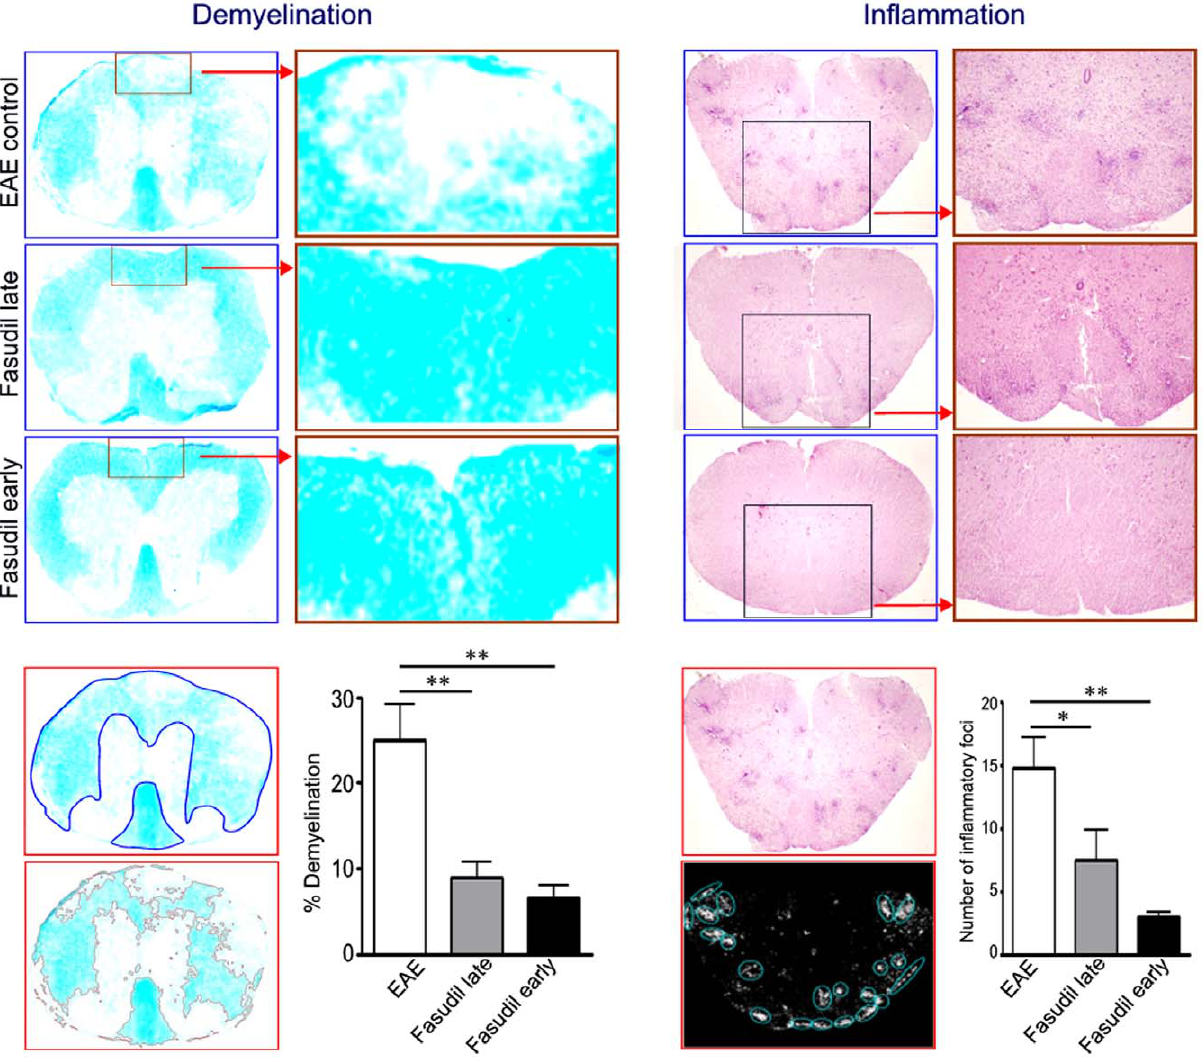
Figure 2. Fasudil inhibits inflammation and improves myelination in spinal cords. Chronic EAE was induced in C57BL/6 mice with MOG 35– 55. Fasudil was injected (i.p.) at 40 mg/kg/d every other day on day 3 p.i. (Fasudil early treatment, n=9) or on day 11 p.i. (Fasudil late treatment, n=9). The injection of normal saline was set up as control (EAE control, n=12) in a similar manner. On day 21 p.i., spinal cords were used for Luxol fast blue and H&E staining. Left) Demyelination stained with Luxol Fast Blue. Total white matter in Luxol Fast Blue was manually outlined, and pixel area (%) of demyelination in total white matter was calculated by Image-Pro Plus software. Right) Inflammation stained with H&E. Color photo in H&E stain was automatically converted to black and white, and number of inflammatory foci ( . 20 mononuclear cells/focus) in whole spinal cords were calculated by Image-Pro Plus software. Quantitative results are analyzed for 6 mice in each group and are representative of 3 experiments with similar results. * p , 0.05, ** p , 0.01. doi:10.1371/journal.pone.0054841.g002 PLOS ONE |